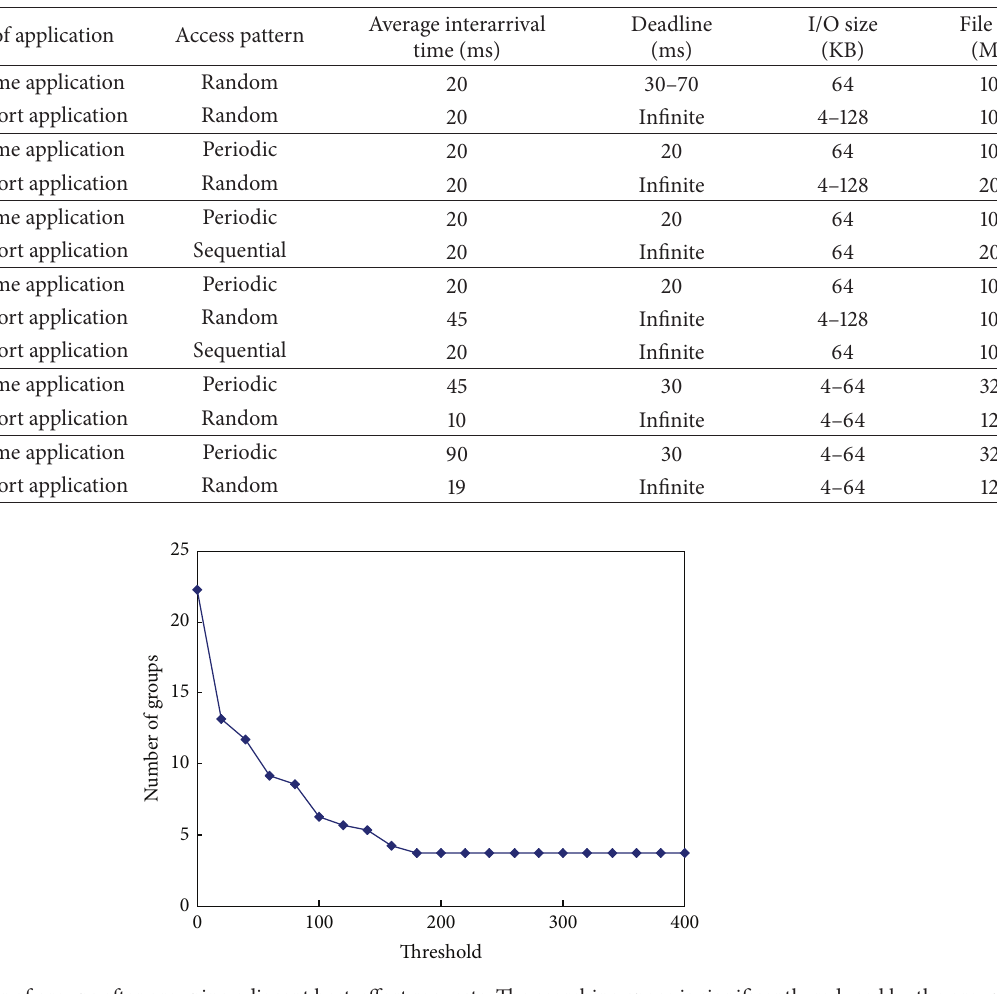
different types of I/O requests. IOZONE is a